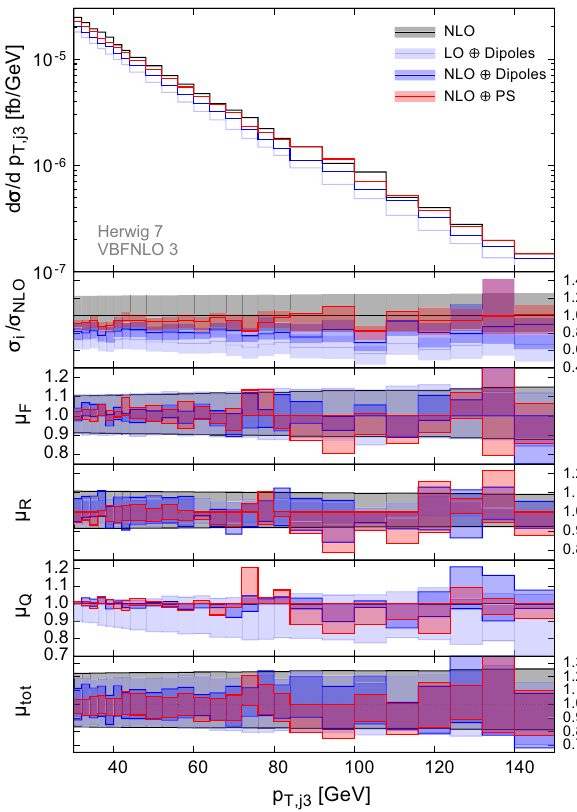
Fig. 6 Same as Fig. 3, showing the separation of the leading charged lepton and the leading jet. Separations with respect to the subleading, secondandthird,jetsshowsimilarfeatures,withincreaseduncertainties for the third jet as the accuracy of its description is lower by one order final state, such as the missing transverse-momentum distri- bution Fig. 4 and the p ⊥ spectrum of the leading charged lepton Fig. 5.